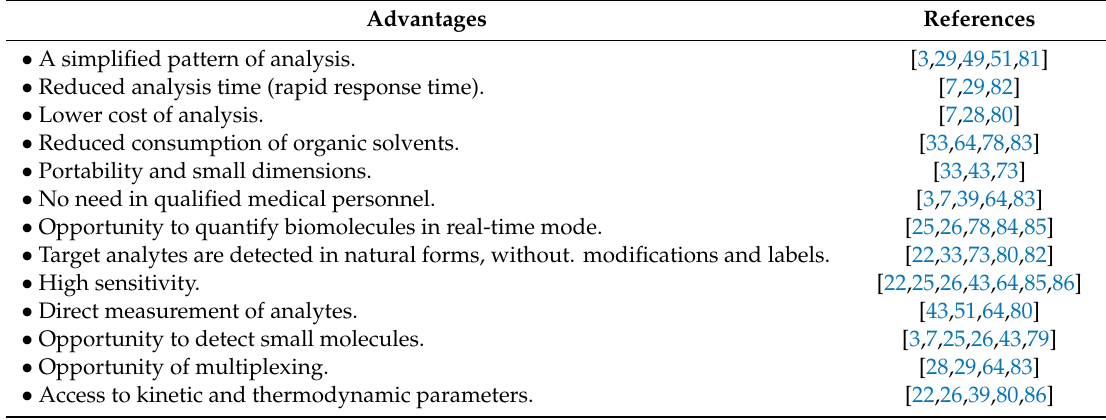
Table 2. Advantages of modern label-free biosensors over similar label-based analytical techniques.